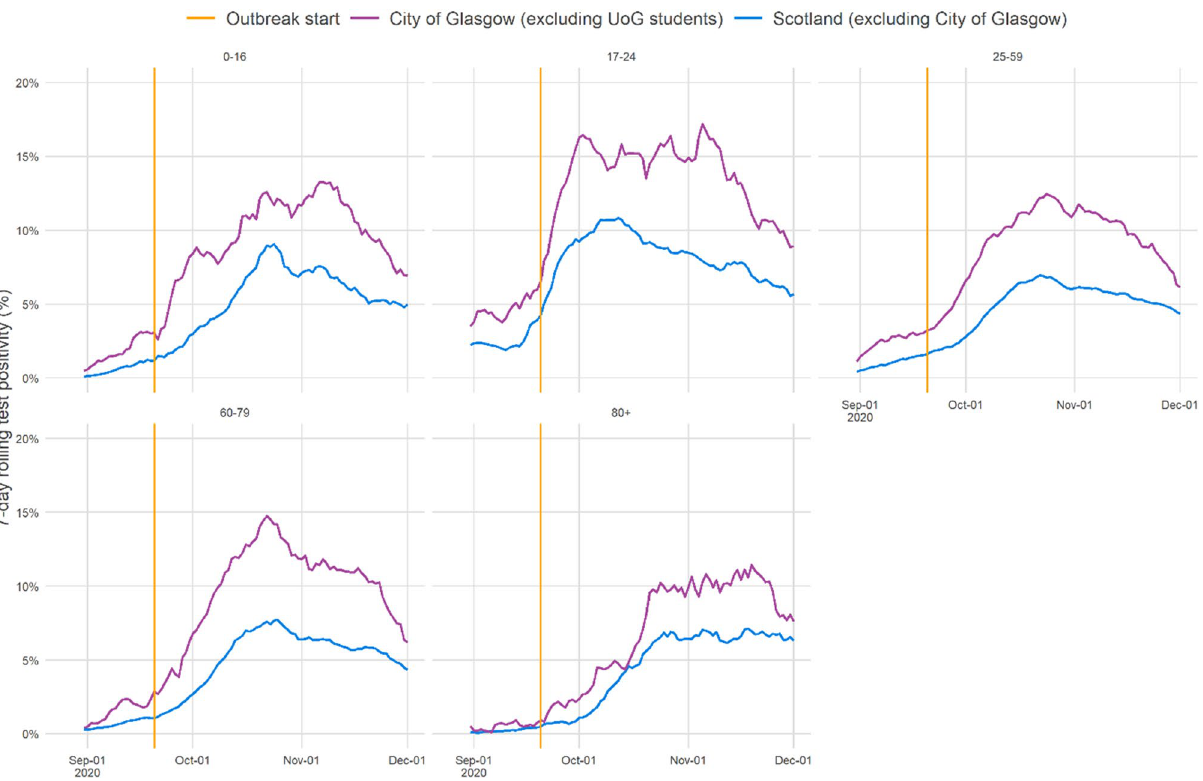
Figure 6. Age-stratified 7-day rolling proportions of PCR-confirmed cases of SARS-CoV-2 infection (test positivity) among all tested individuals in the City of Glasgow community [excluding University of Glasgow (UoG) students], and in comparison with the rest of Scotland, excluding the City of Glasgow. The vertical lines indicate the start of the UoG student halls cluster around 19th September